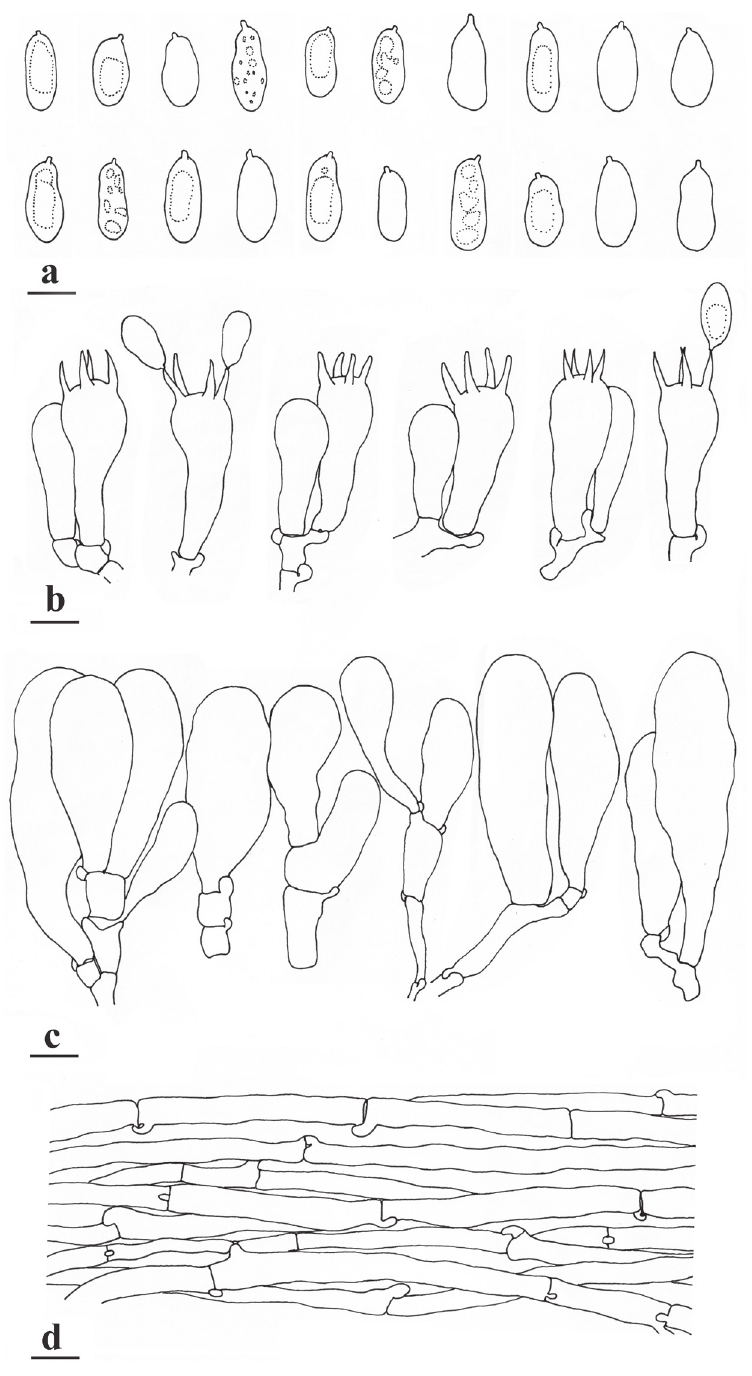
Figure 3. Microfeatures of Pseudosperma arenarium (holotype) a basidiospores b basidia c cheilocystidia d pileipellis. Scale bars: 10 μm ( a–d ). Line drawings by Li